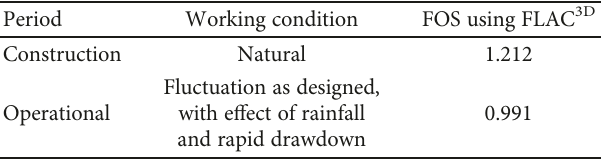
Figure 20: Distribution of water pressure of Dasha bank slope (rainfall in 2 hours is 94.7mm). Table 5: Factor of safety of Dasha landslide under di ff erent working conditions in di ff erent